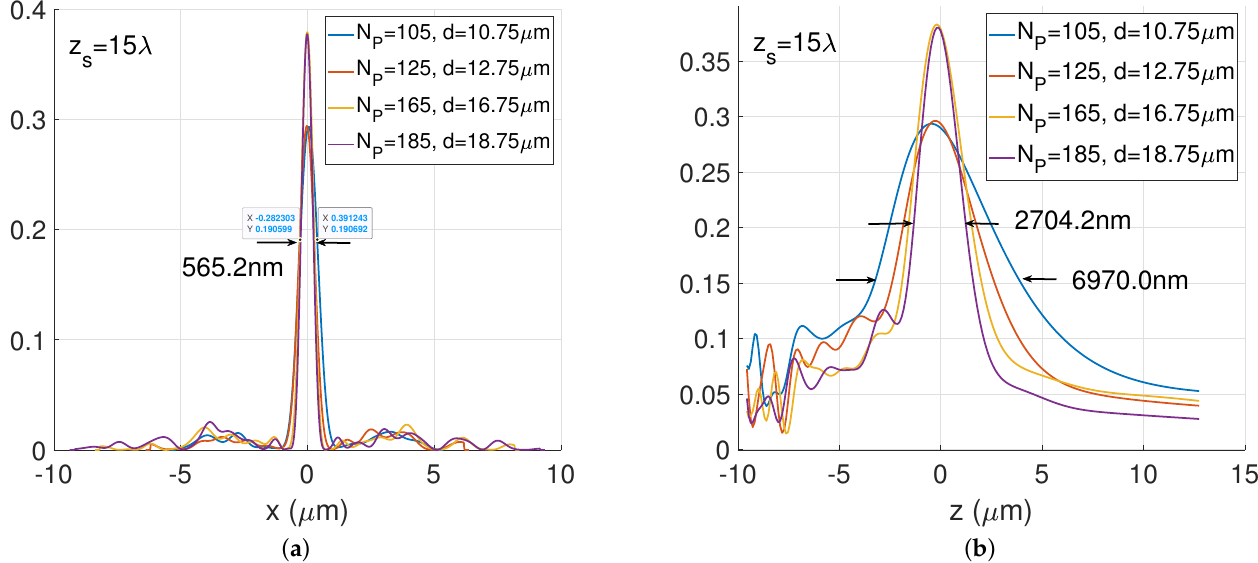
Figure 5. Design of d -wide silver plasmonic metalense consisting of N p silver-nanoridges and air-gap focusing a normal incident TM-polarized plane wave at a wavelength λ = 0.637 µ m at a distance of 15 λ . Line scans of the normalized magnetic field intensity in the transverse ( z f = 0) ( a ) and in the longitudinal x = x 0 ( b ) focal plane respectively, for four values of the couple ( N p , d ) : ( N p , d ) ∈ { ( 105,10.75 µ m ) , ( 125,12.75 µ m ) , ( 165,16.75 µ m ) , ( 185,18.75 µ m ) } . Numerical parameters: λ = 0.637 µ m, h = 400 nm, TM polarization. ( a ) | H y ( x ,0 ) | 2 /